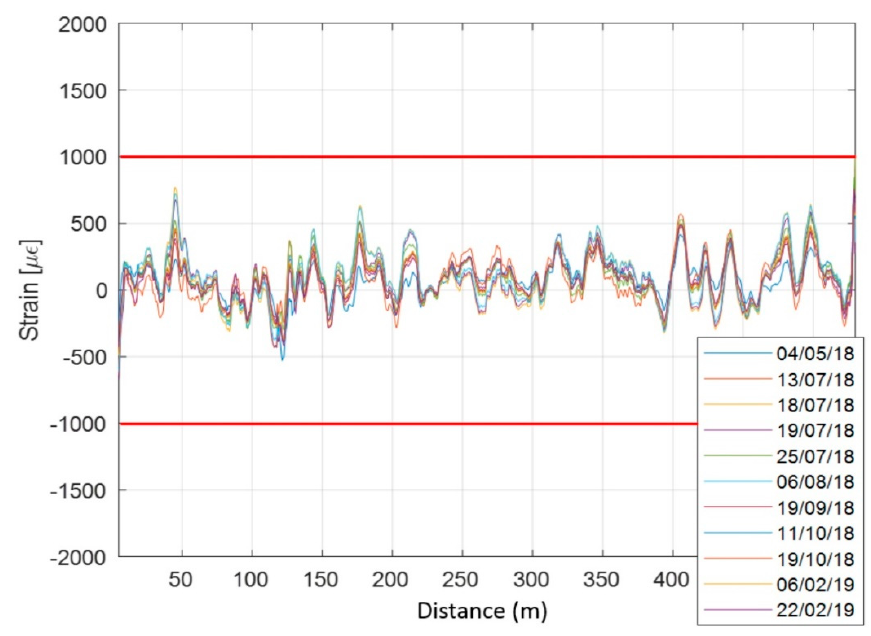
Figure 21. DOFS strain profiles along the marble buttress from January 2018 to February 2019 and alarm thresholds (red lines).